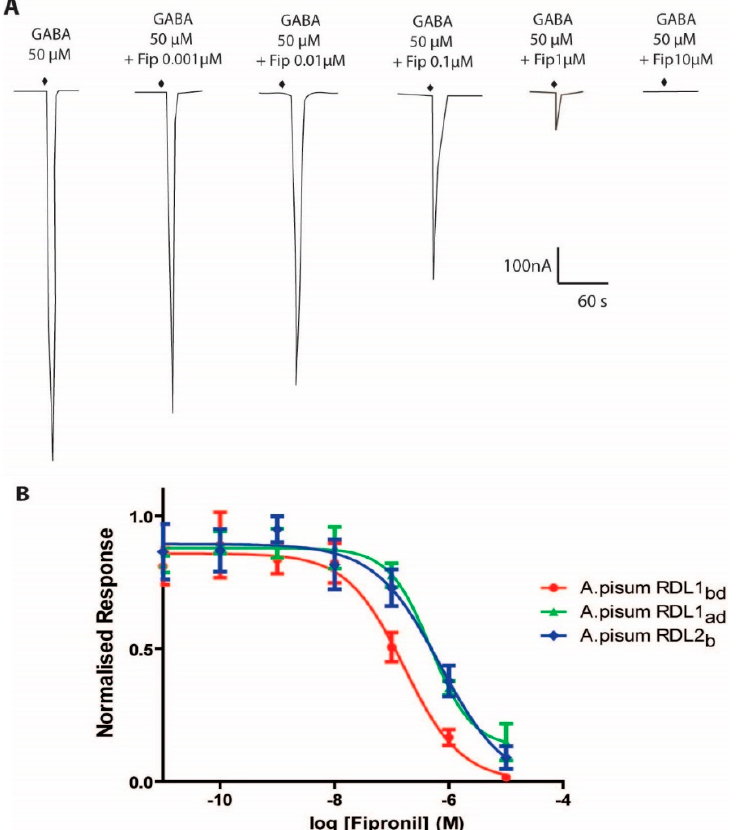
Figure 6. Effects of fipronil on currents activated by GABA at EC 50 in X. laevis oocytes expressing